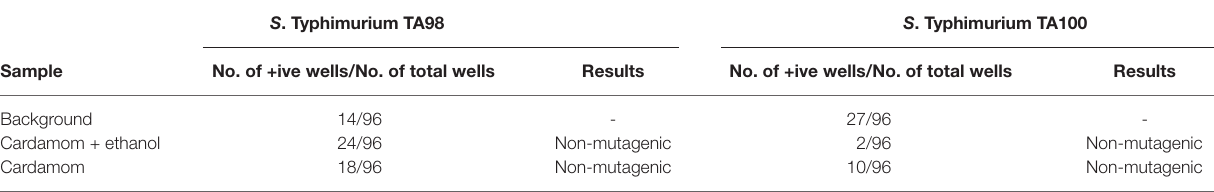
TABLE 3 | The mutagenic activities of green cardamom essential